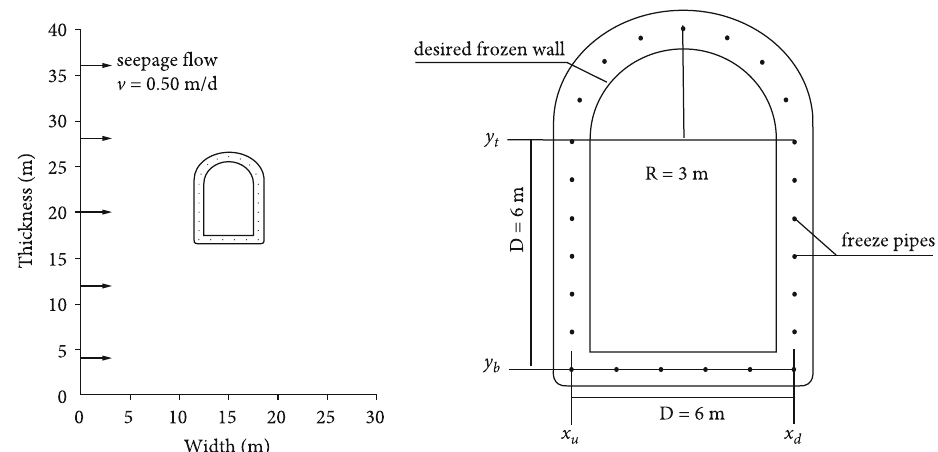
Figure 2: Dimensions of the gravel formation and tunnel connected aisle.